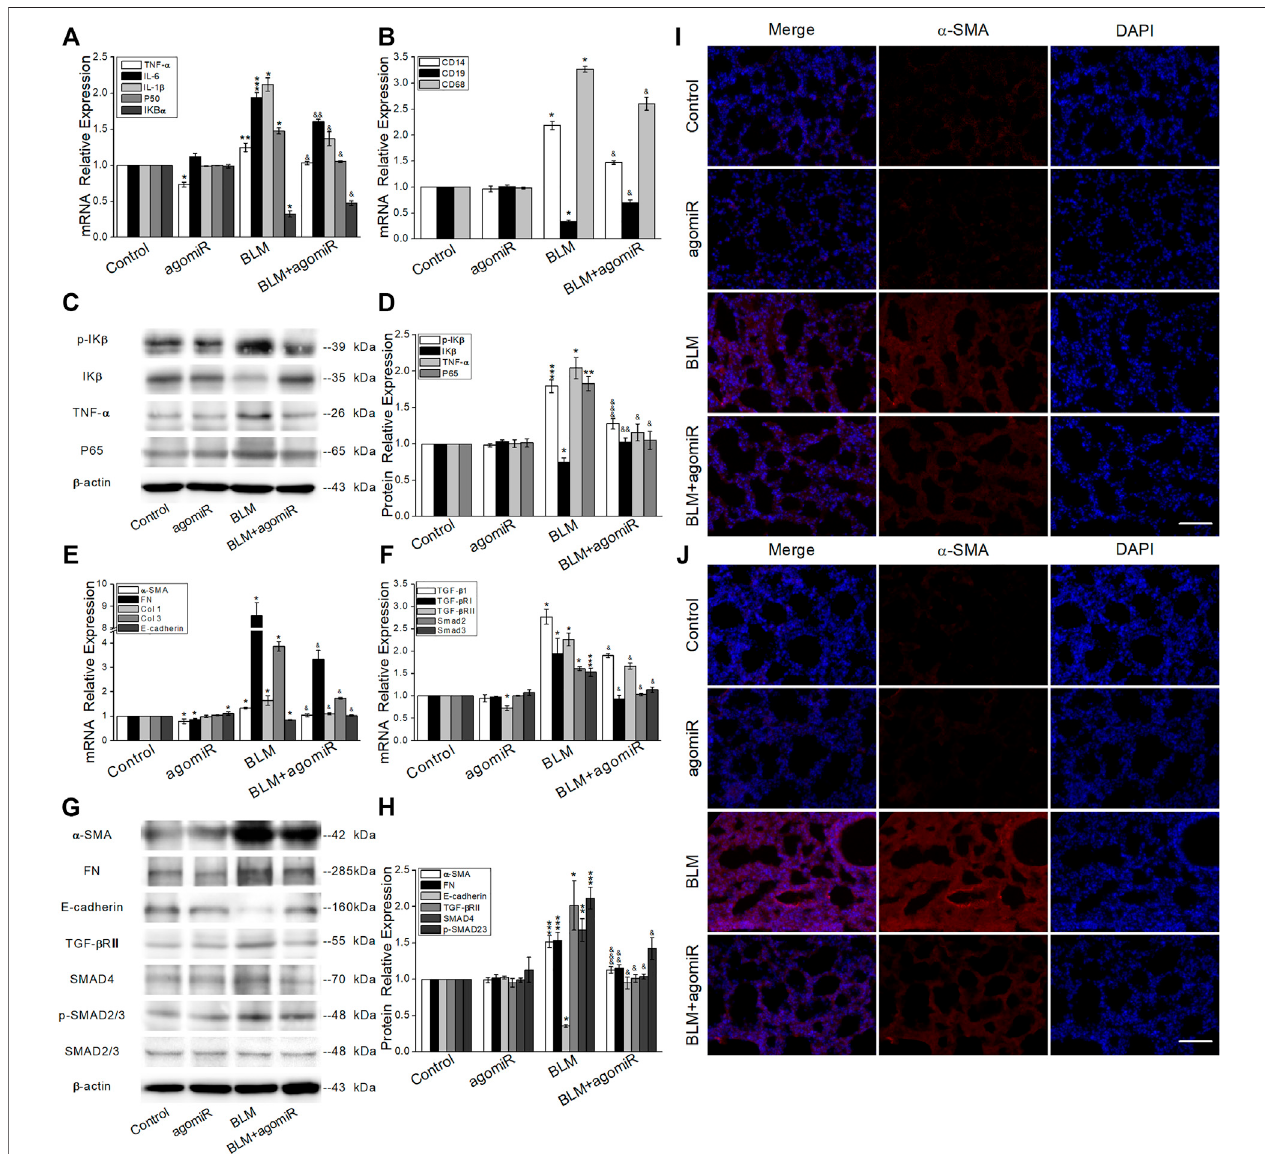
FIGURE6| MiR-130a-3preducestheexpressionofin fl ammatory-and fi brotic-relatedfactors. (A-B) qRT-PCRquantitationofmRNAexpressionsofin fl ammation- related genes. * p < 0.05, ** p < 0.01, *** p < 0.001, versus the control group; & p < 0.05, && p < 0.01, versus the BLM group, by the Mann – Whitney U test, n = 3 – 5. (C-D) Representative and statistical data of NF- κ B signal pathway protein levels. * p < 0.05, ** p < 0.01, *** p < 0.001, versus the control group; & p < 0.05, && p < 0.01, &&& p < 0.001, versus the BLM group, by the Mann – Whitney U test, n = 3 – 5. (E-F) qRT-PCR quantitation of mRNA expressions of fi brosis-related genes. * p < 0.05, *** p < 0.001,versusthecontrolgroup; & p < 0.05,versustheBLMgroup,bytheMann – Whitney U test, n =3 – 5. (G-H) RepresentativeandstatisticaldataofTGF- β /Smadsignal pathwayproteinlevels.* p < 0.05,** p < 0.01,*** p < 0.001,versusthecontrolgroup; & p < 0.05, && p < 0.01, &&& p < 0.001,versustheBLMgroup,bytheMann – Whitney U test, n = 3 – 5. Immuno fl uorescence for α -SMA in the (I) in fl ammatory phase and (J) fi brotic phase. α -SMA-positive (red) and DAPI (blue). Scale bar = 50 μ m.